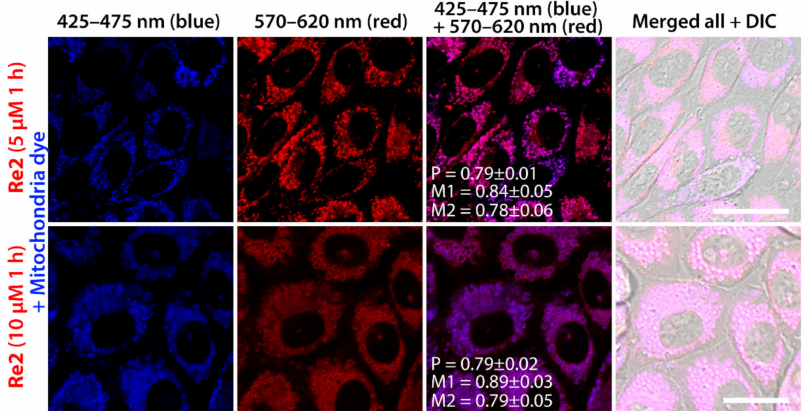
Figure 8. Subcellular distribution of BioTracker 405 Blue Mitochondria Dye (blue, 425–475 nm), Re2 (red, 570–620 nm, top: 5 µ M, 1 h, bottom: 10 µ M, 1 h) in living CHO-K1 cells. Pearson’s (P) and Manders’ overlap coefficients (M1—fraction of first channel that overlaps second channel, M2— fraction of second channel that overlaps first channel) are presented as mean ± standard deviation calculated for 25 cells. Scale bar 20 µ m.